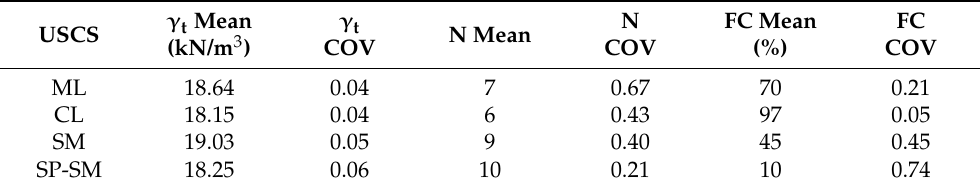
Figure 6. Soil-distribution profile of actual boreholes along A- A’. Table 1. The relevant parameters and coefficients of variance in the liquefaction-potential evaluation of a construction project in northern Taiwan.